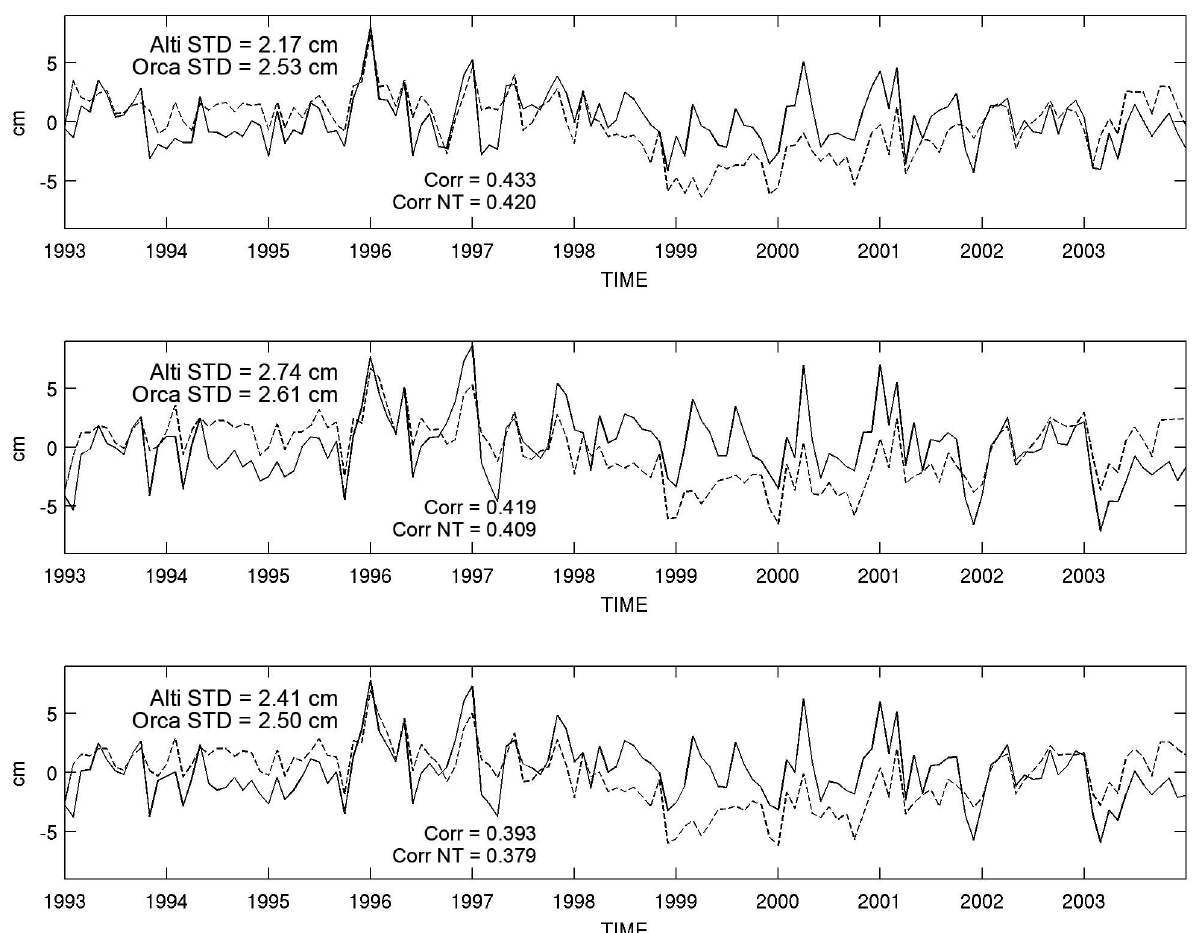
Fig . 6. – Time-series (with the seasonal cycle and trends removed) of ORCA sea surface height (dashed-line) and altimetry (solid-line) for the WMED (top), EMED (middle) and whole Mediterranean (bottom). STD refers to the standard deviation values for each time-series. ‘Corr’ and ‘Corr NT’ refer to correlation and de-trended correlation